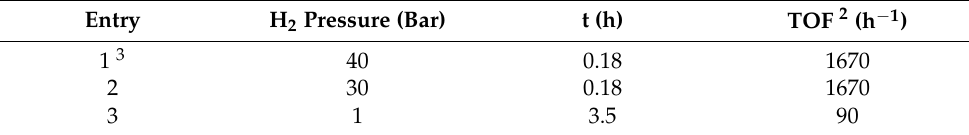
Table 1. Hydrogenation of diethyl phthalate with Rh(0) NPs@TiO 2 nanocatalyst 1